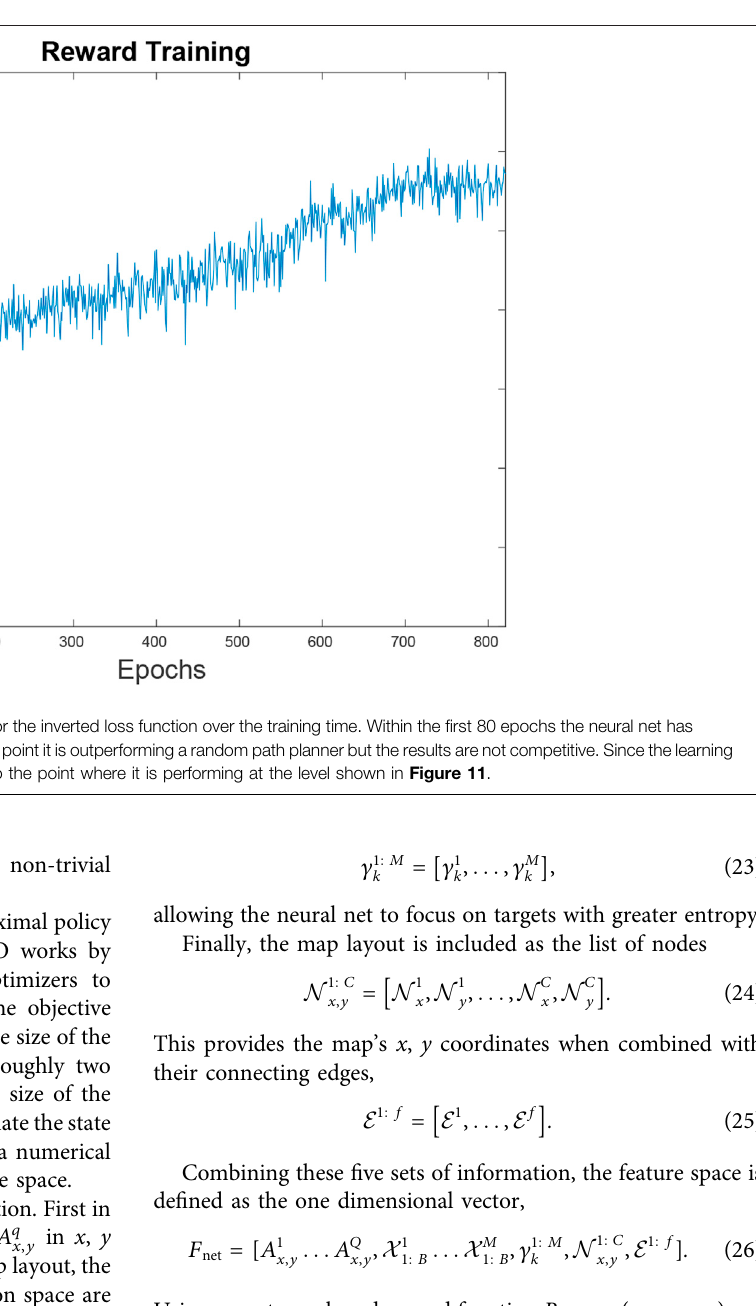
Frontiers in Robotics and AI |